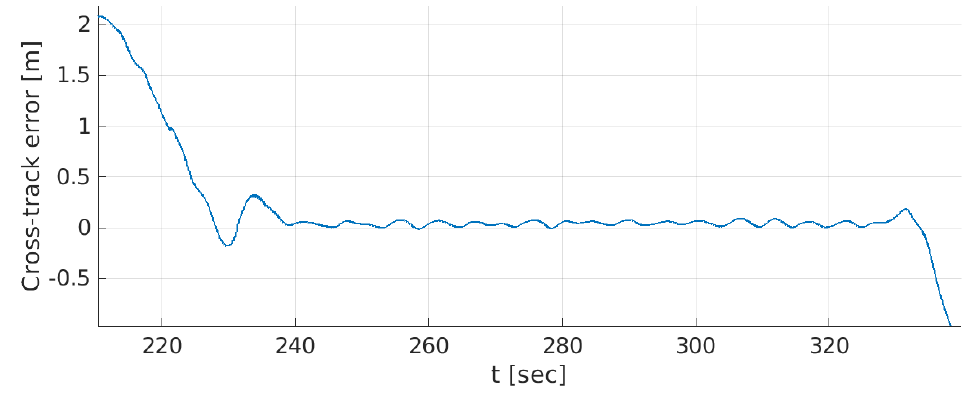
Figure 21. Cross-track error, employing the ALICE configuration along a single transect.